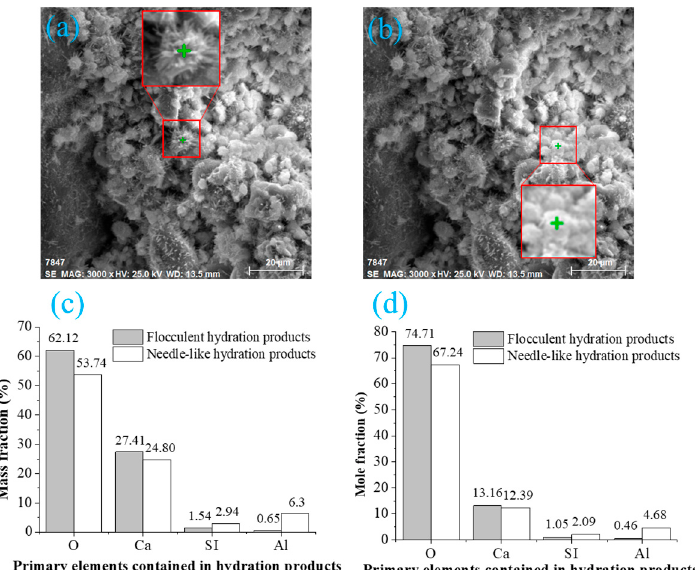
Figure 15. Locations and testing results of selected spots for energy-dispersive spectroscopy spot element testing of hydration products for a curing time of 7 days: ( a ) locations of testing spots in needle-like hydration products; ( b ) locations of testing spots in flocculent hydration products; ( c ) concentrations (wt. %) of elements contained in hydration products; and ( d ) mole fractions (at. %) of elements contained in hydration products.